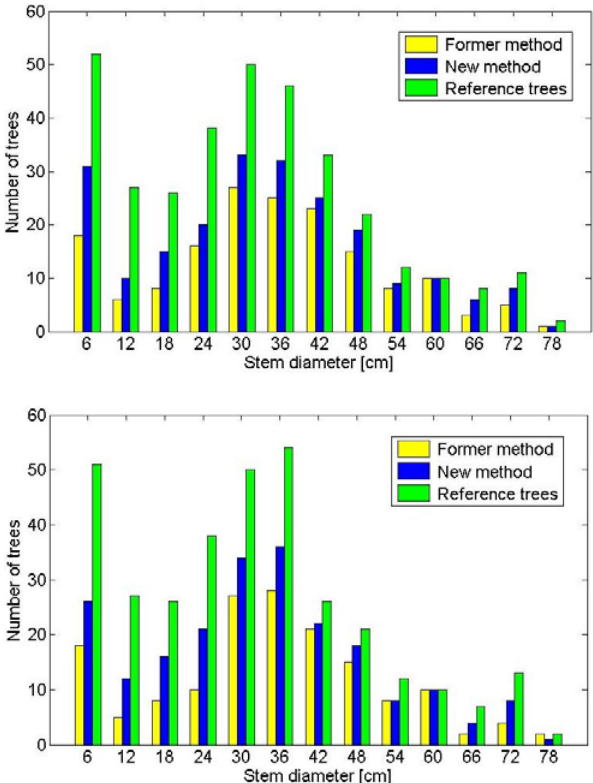
Figure 7 Distribution of stem diameter vs. tree detection improvement, top: leaf-off season bottom: leaf-on season